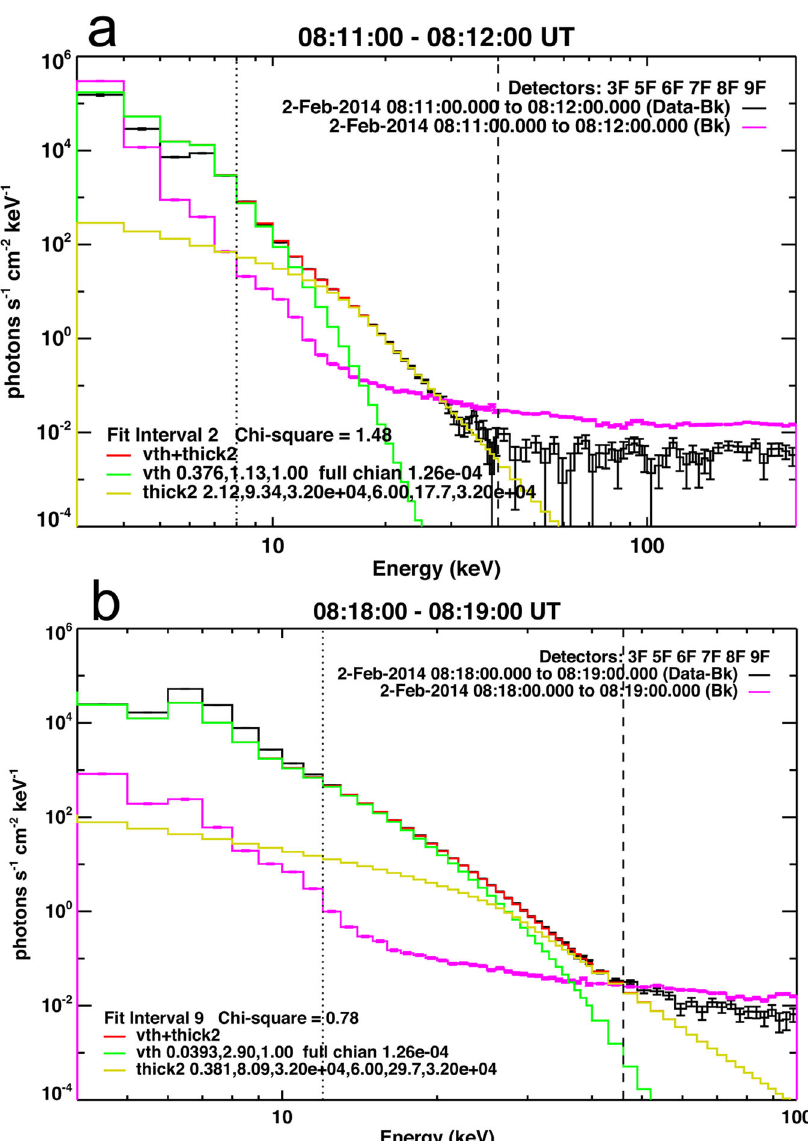
Fig. 7 RHESSI photon spectra accumulated around 08:12 UT and 08:19 UT during the quoted 1-min intervals on 2014 February 2. a 08:12 – 08:12 UT. b 08:18 – 08:19 UT. The spectra are fi tted by combining the vth and thick2 functions (see Methods, subsection RHESSI spectrum). The black line shows the photon spectrum with the background subtracted. The pink line shows the background. The green and yellow lines display the fi tting with the single- temperature thermal model and the thick-target nonthermal model, respectively. vth is used to fi t the thermal portion of the spectra, generally from 4 keV to between 20 and 25 keV depending on the attenuator state. thick2 is used to fi t Thick-Target Bremsstrahlung X-ray/gamma-ray spectrum from an isotropic electron distribution. Bk indicates the background photon fl ux. Data-Bk indicates the observational photon fl ux with the background fl ux subtracted. Detectors indicate the detectors that used to obtain the photon fl ux. The error is the square root of the counts used in the fi tting. When combining time bins, these errors are averaged. Source data are provided as a Source Data fi